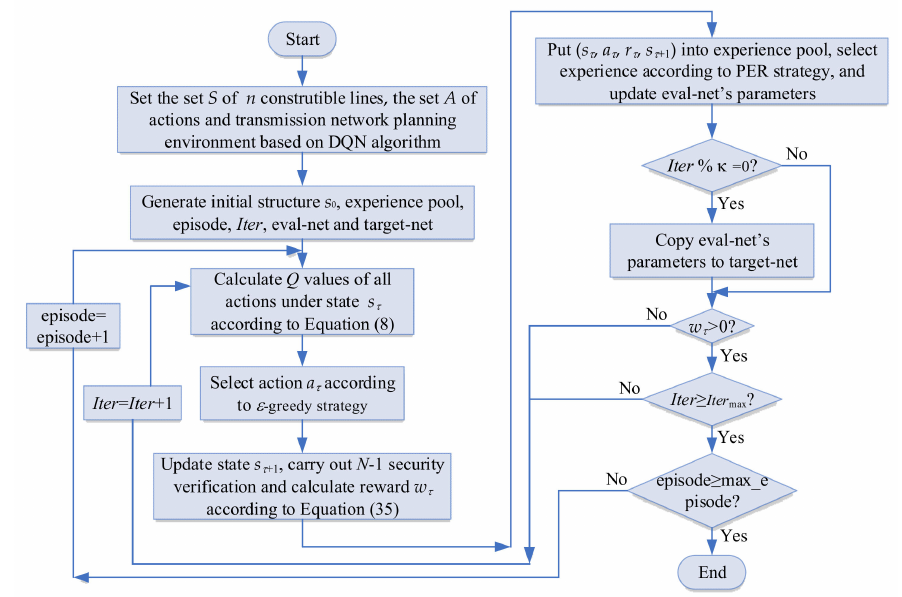
Figure 4. Planning procedure of the proposed flexible TNEP